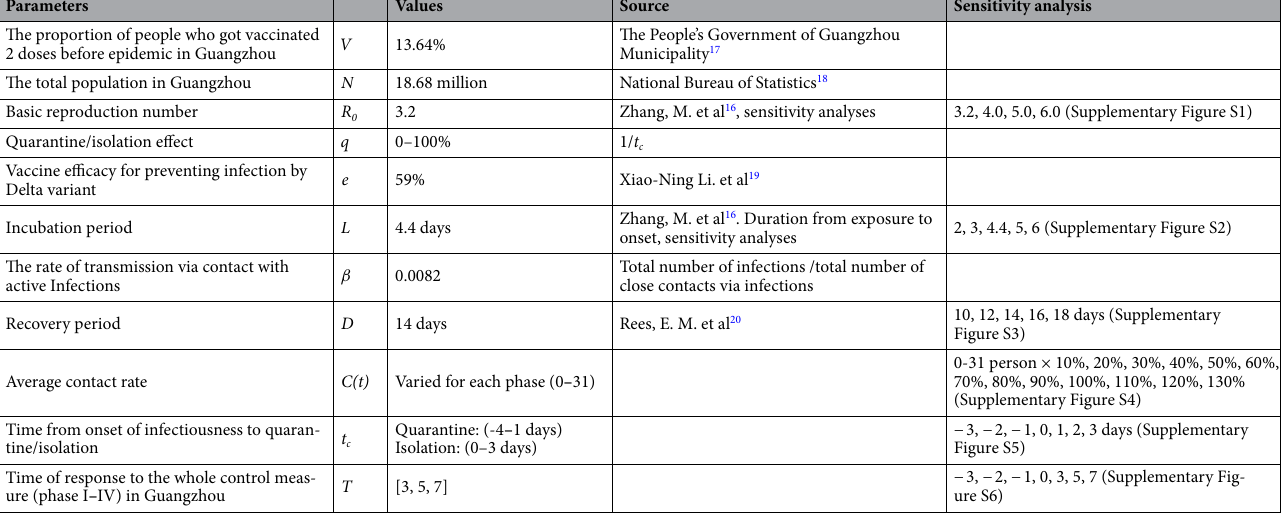
Table 1. Epidemiological